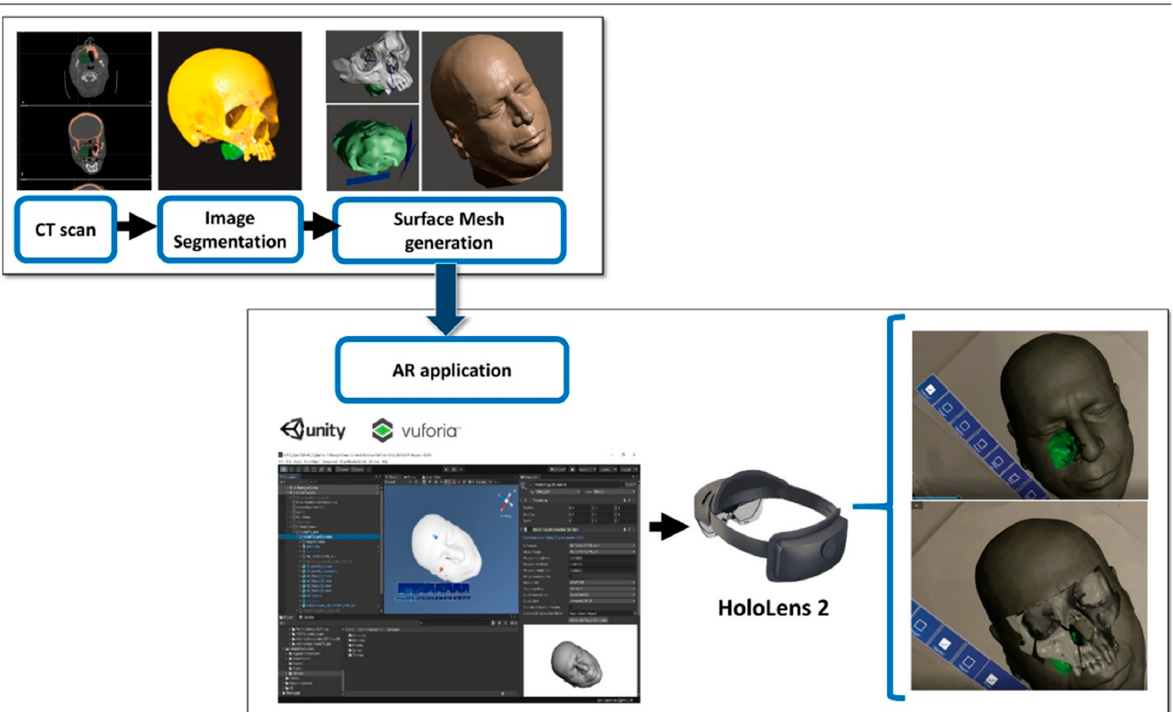
Figure 2. The steps for preparation of the AR guidance application for HoloLens 2 glasses (Redmond, Washington state, USA).